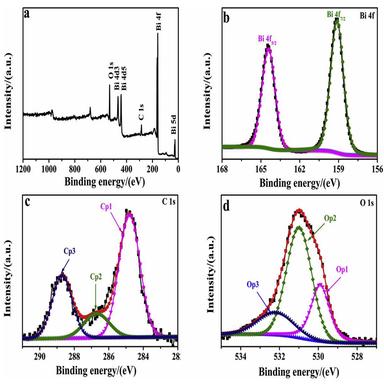
XPS spectra of Bi2O2CO3 microspheres: (a) survey, (b) Bi 4f, (c) C 1s and (d) O 1s.